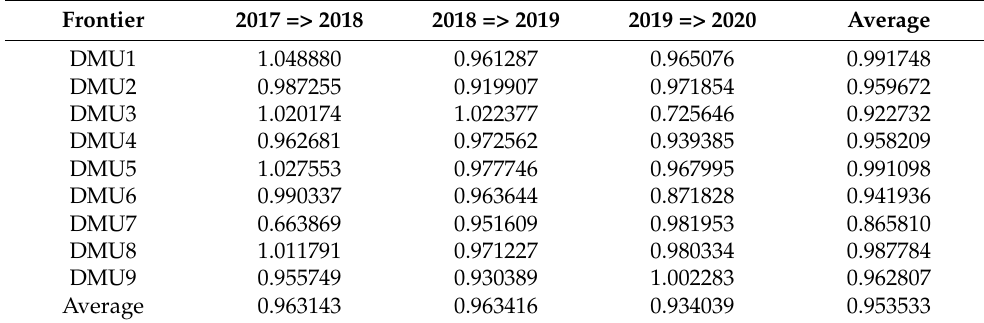
Table 4. Frontier-shift index of DMUs from 2017 to 2020 .